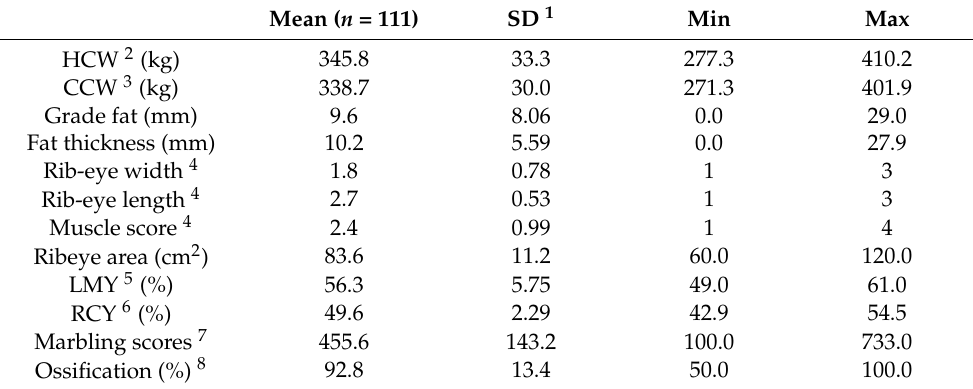
Table 1. Descriptive statistics of carcass characteristics of the population used to obtain the prediction equations between the camera vision system values and whole carcass and primal composition (fat, lean, and